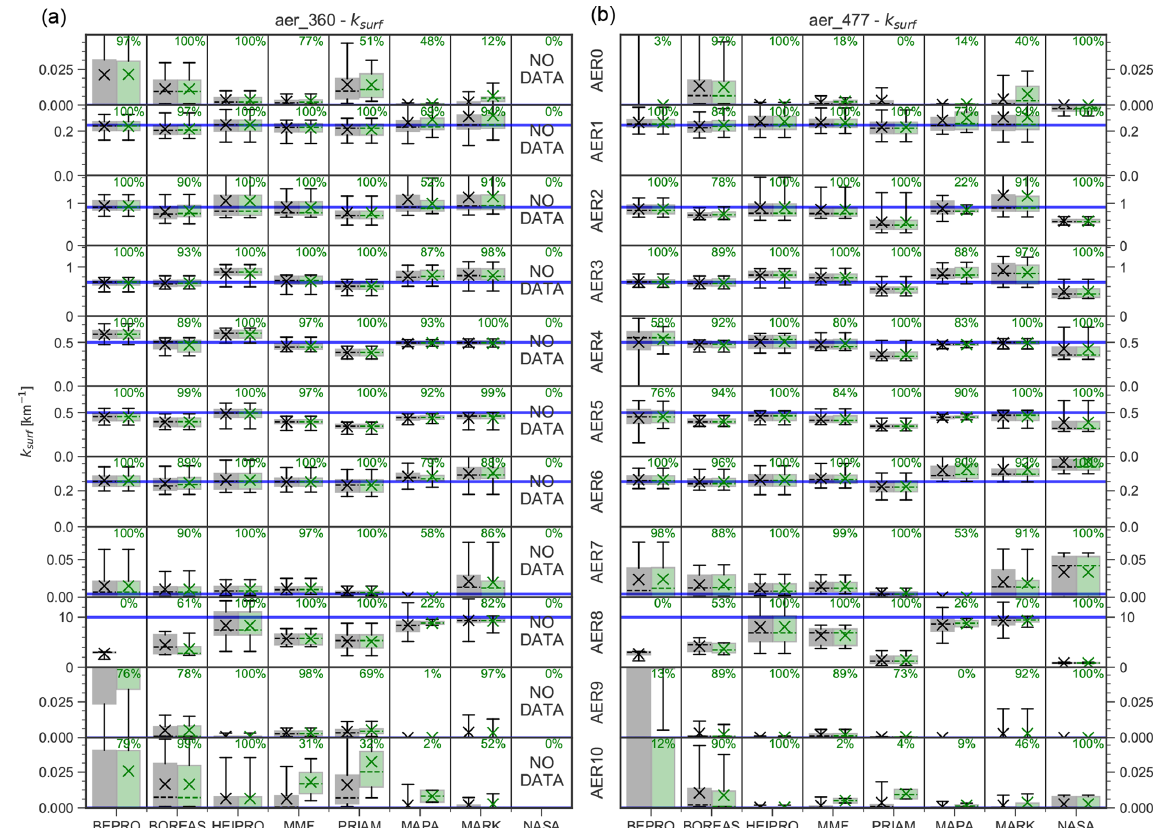
Figure 19. Box–whisker plots of the retrieved surface aerosol extinction at 360nm (a) and 477nm (b) for the different aerosol scenarios (rows) and retrieval algorithms (columns) based on retrievals using noisy dSCDs. Crosses show the mean, and dashed horizontal lines show the median. Shaded areas indicate the (25%–75%) percentile, and whiskers show the (5%–95%) percentile. The true AOT is shown as the blue horizontal line. For each algorithm, all data are shown on the left in black, and data marked as valid are on the right in green. Also shown is the percentage of valid